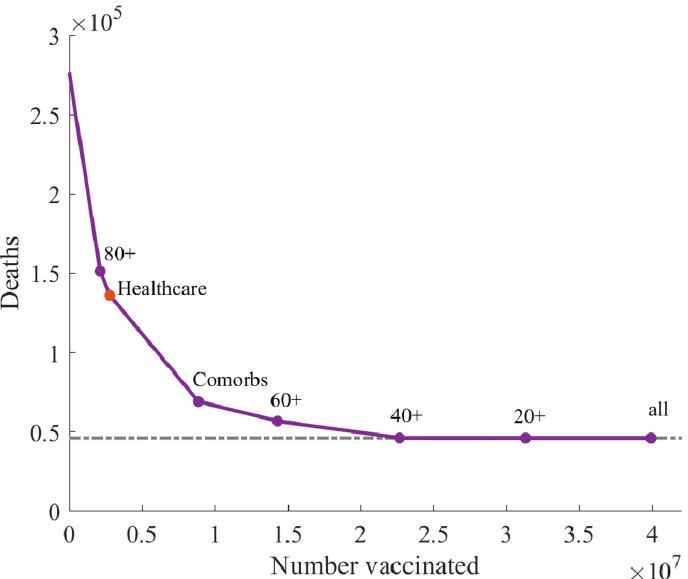
Fig 6. Optimal vaccination ordering for age, comorbidity and HCW groups in a scenario with a type 1 vaccination and low level social measures ( R = 1.8).